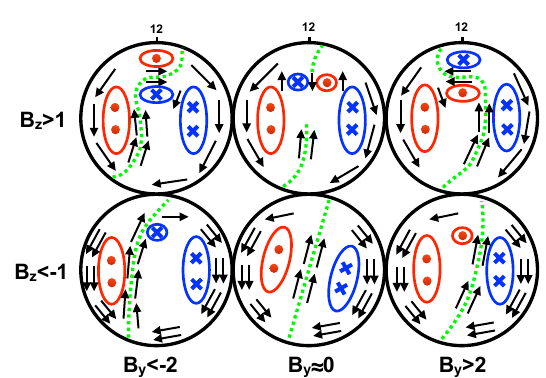
Figure 10. Schematic drawing of Hall current distributions for var- ious IMF orientations. Colored ellipses with dots and crosses rep- resent upward and downward FAC regions, respectively. Region 2 FACs have been omitted. The dotted green lines mark the separatrix between the two convection cells. Black arrows indicate the flow of Hall currents. The image represents the situation in the Northern Hemisphere for summer